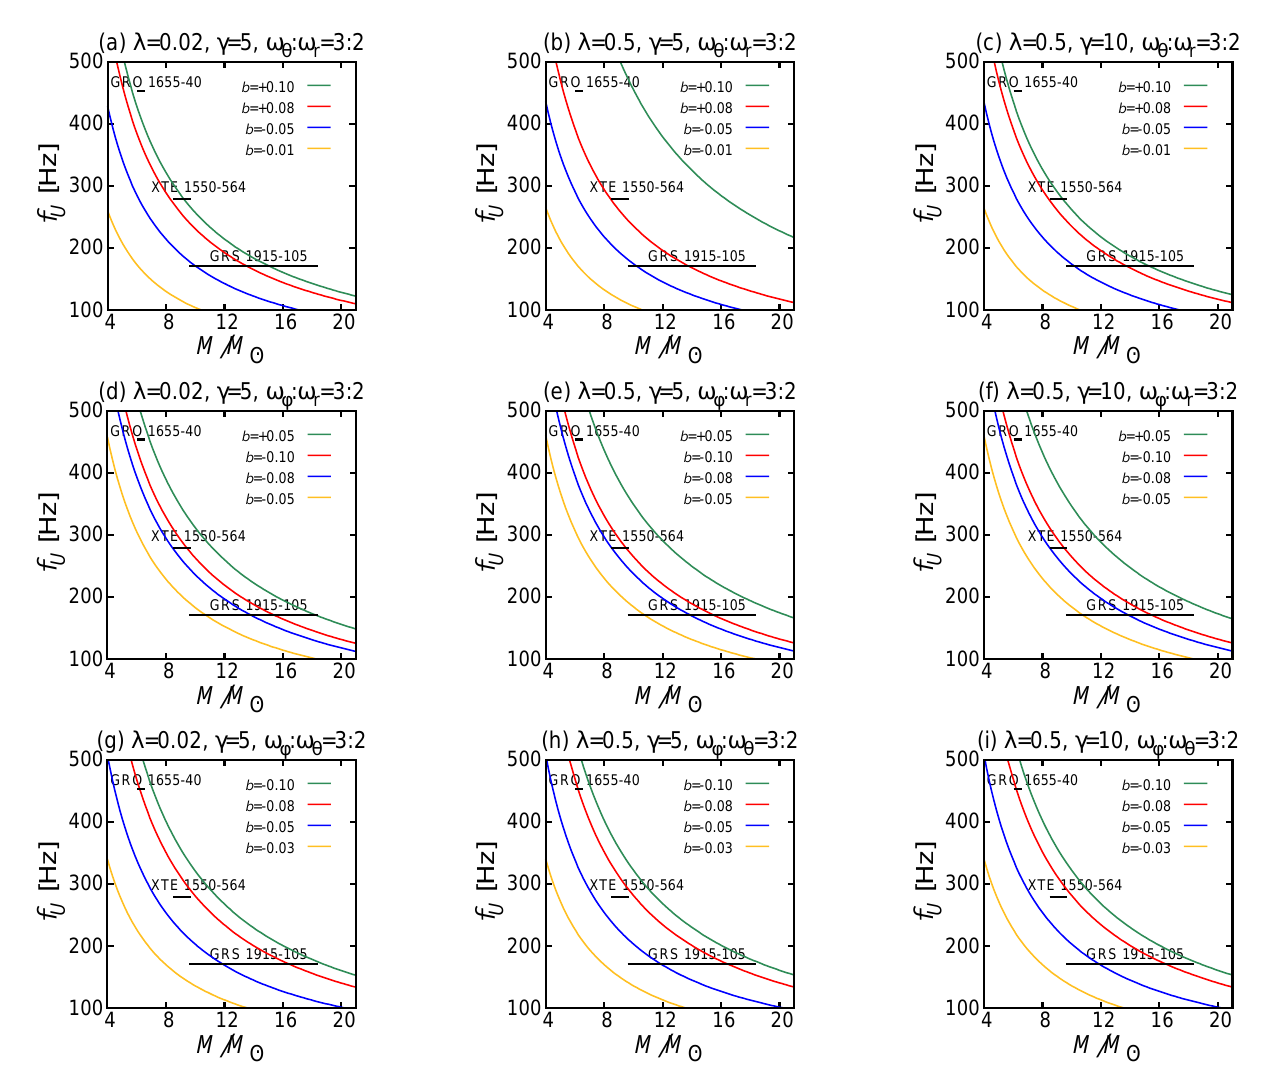
Figure 11. The upper frequency f U (Hz) and mass M / M (cid:12) relations for different parameters λ , γ , Figure 11: The upper frequency f U (Hz) and mass M/M relations for different parameters and b with the cases of ω θ : ω r = 3 : 2, ω φ : ω r = 3 : 2, and ω φ : ω θ = 3 : 2. GRO 1655-40, XTE ⊙ λ , γ and b with the cases of ω θ : ω r = 3 : 2, ω ϕ : ω r = 3 : 2 and ω ϕ : ω θ = 3 : 2. And GRO 1550-564, and GRS 1915+105 are denoted by black horizontal 1655-40, XTE 1550-564 and GRS 1915+105 are denoted by black horizontal lines.